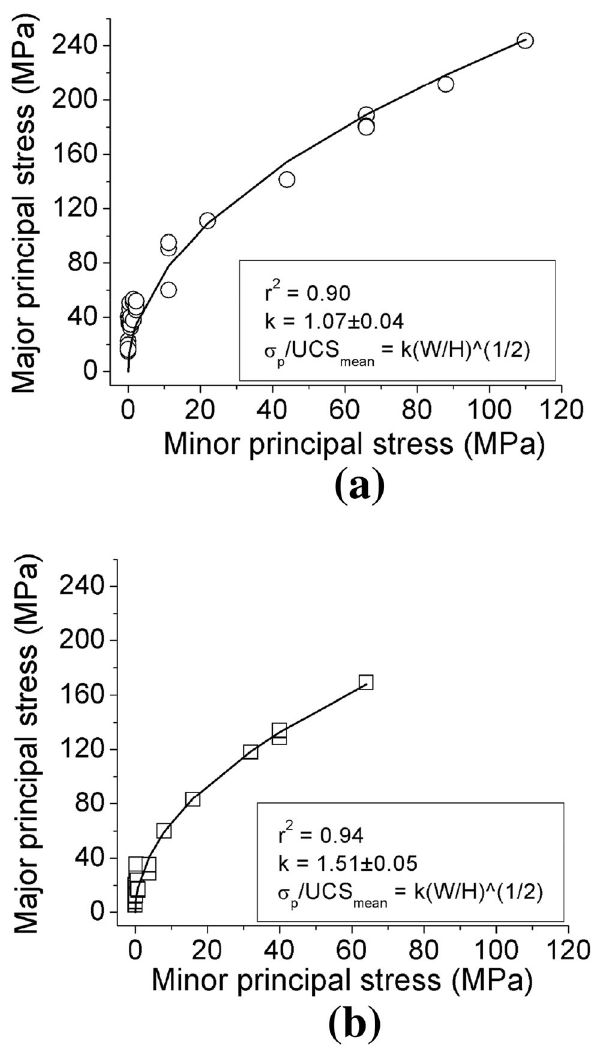
Fig. 10 Results of the triaxial compressive tests fitted with the various different empirical methods ( a 0 (cid:3) of the included angle and b 30 (cid:3) of the included angle)